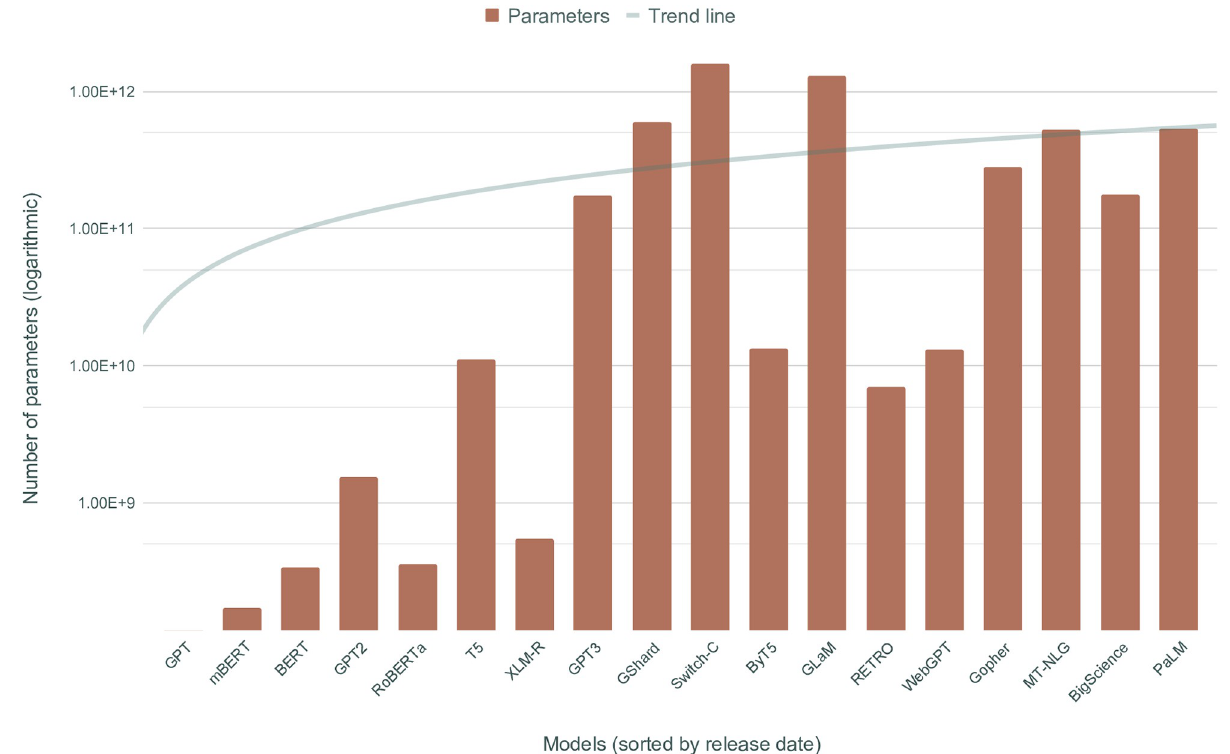
Fig 2. N. of parameters (log scale) in the largest version of recent contextualized LMs, ordered by release date.